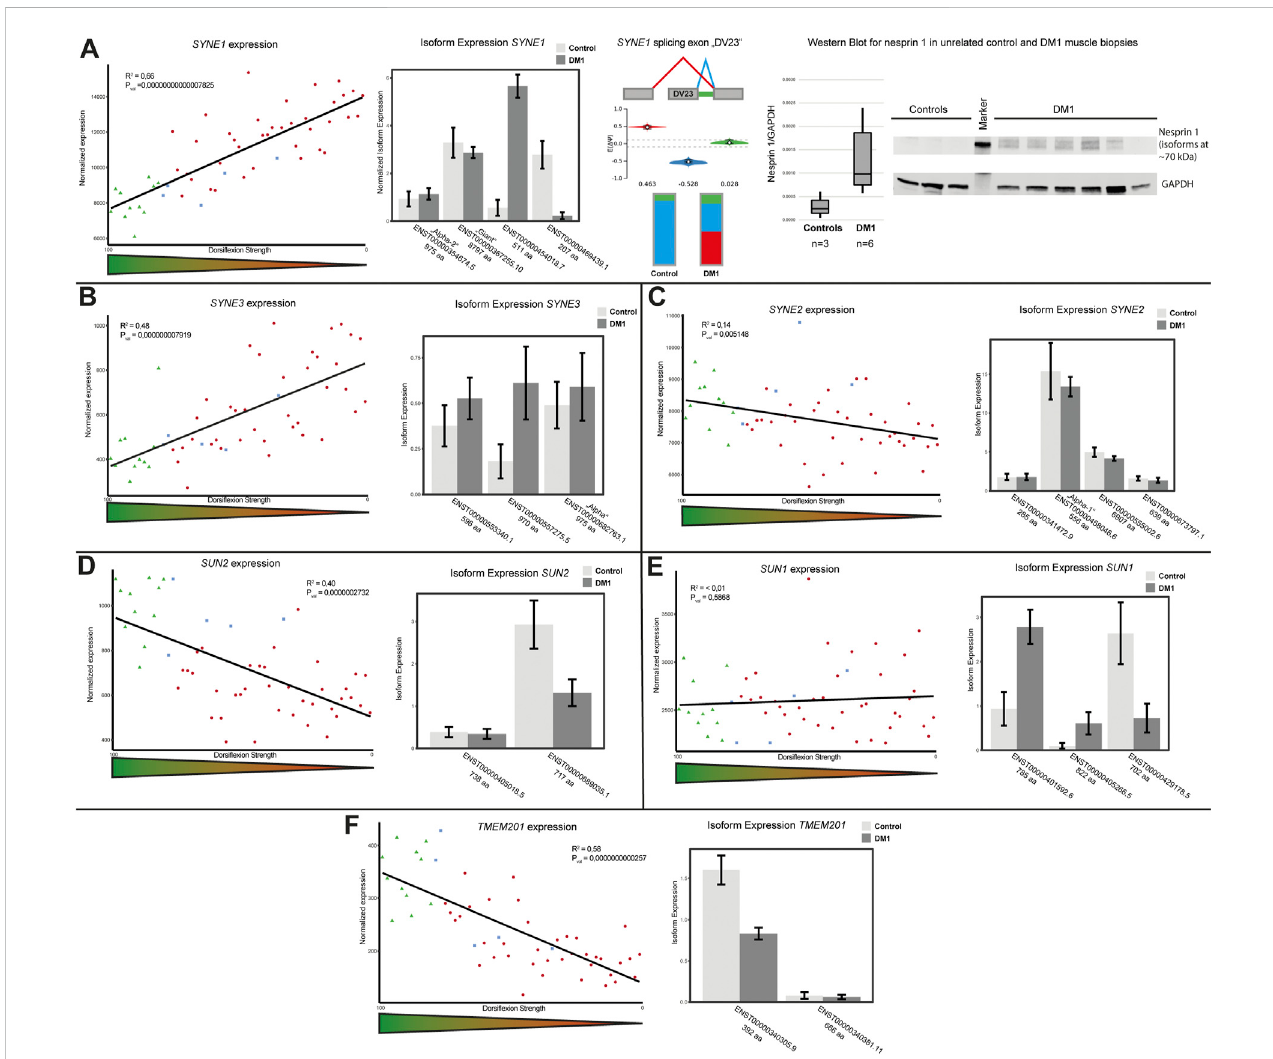
FIGURE 2 LINC (linker of nucleo- and cytoskeleton) complex protein expression and splicing is altered in DM1. (A) SYNE1 gene expression is inversely correlated with dorsi fl exion strength (left panel),there isa switch inisoform expression(second panel) and the muscle-speci fi c DV23 exon ispreferentially spliced out in DM1 (third panel). Western blot analysis con fi rms the expression changes for short nesprin isoforms (fourth panel). (B) SYNE3 gene expression is inversely correlated with dorsi fl exion strength (left panel), there is a switch in isoform expression (right panel). (C) SYNE2 gene expression slightly correlates with dorsi fl exion strength (left panel), there appears to be a general slight downregulation of several isoforms (right panel). (D) SUN2 gene expression correlates withdorsi fl exionstrength(leftpanel),themainmuscleisoformisdownregulated(rightpanel). (E) SUN1 geneexpressionisunaffected(leftpanel),butthereisa switch in isoform expression (right panel). (F) TMEM201 gene expression correlates with dorsi fl exion strength (left panel), the main muscle isoform is downregulated (right